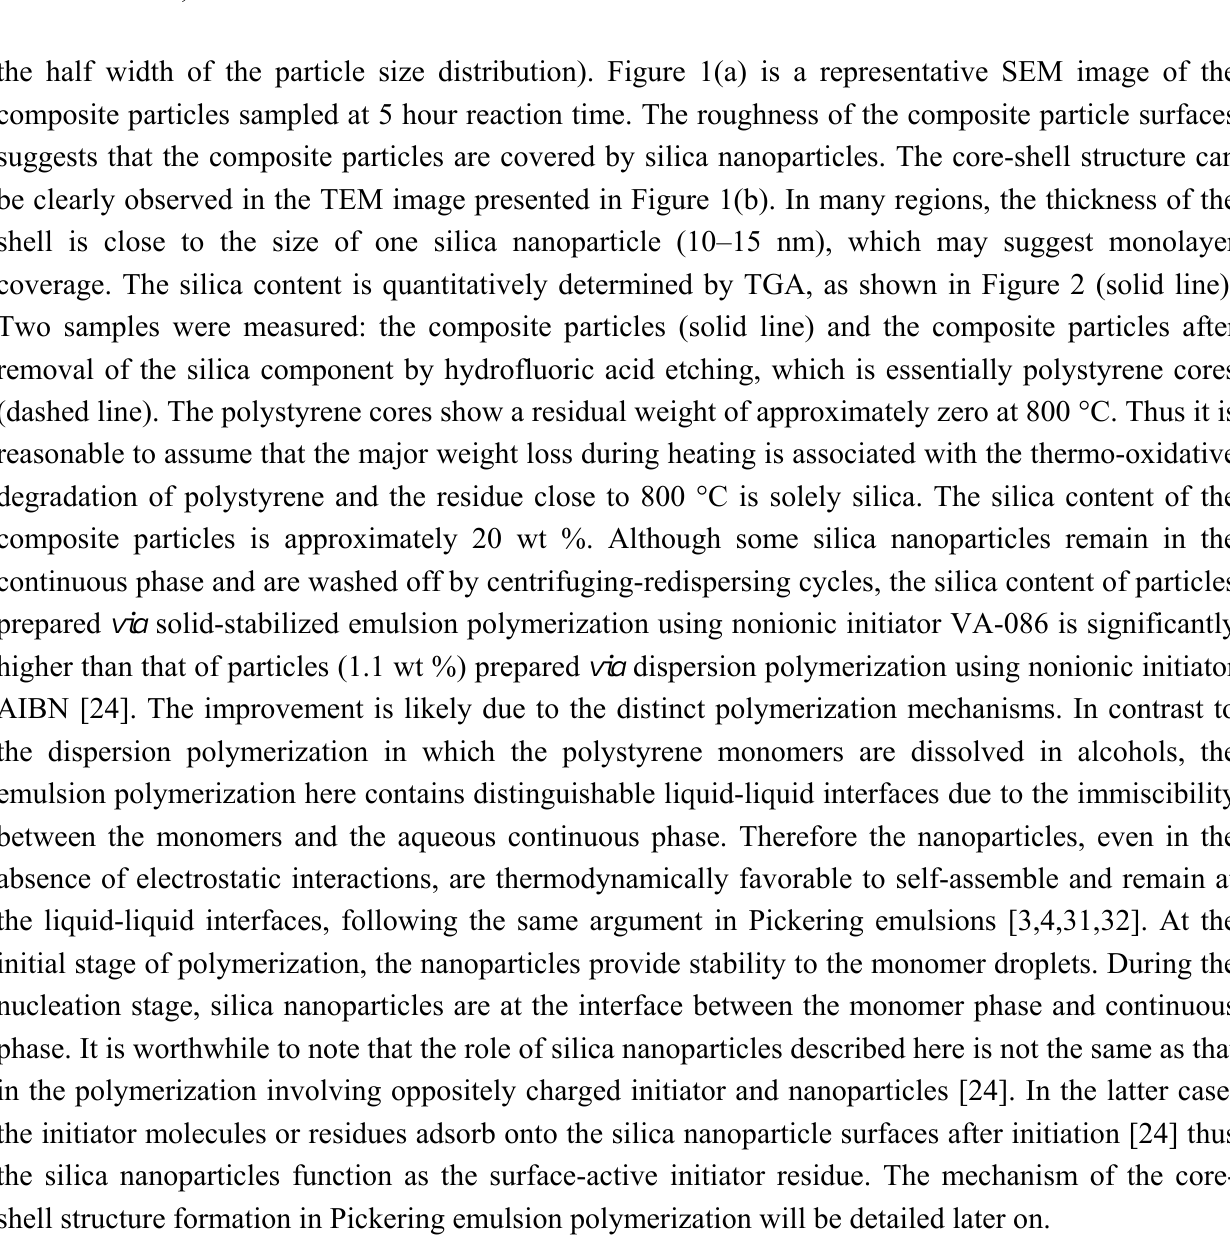
Figure 1. An SEM image (a) of the nanocomposite particles prepared using VA-086 as